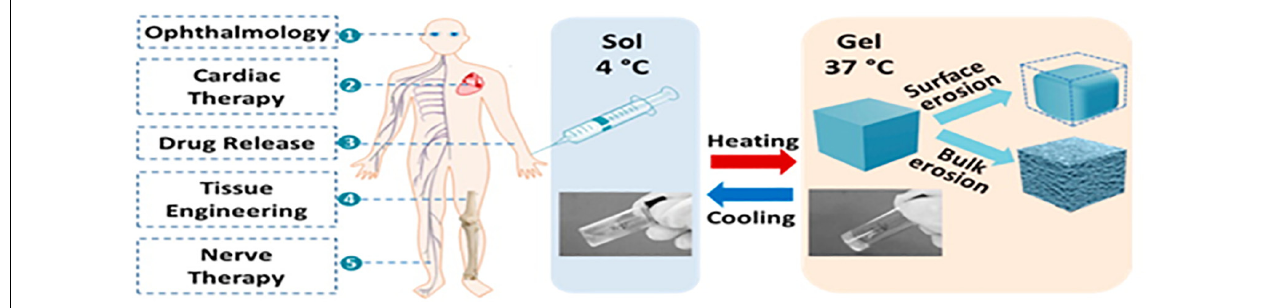
FIGURE 1 | A graphical abstract of thermo-gelling systems and their biomedical applications. Reproduced with permission from Liow et al. (2016). Copyright 2016 American Chemical